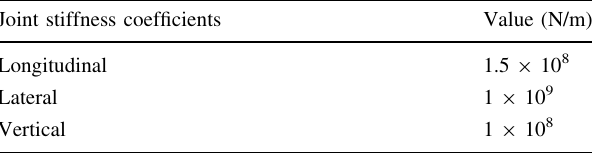
Table 1 The joint stiffness coefficients between tunnel segments Joint stiffness coefficients